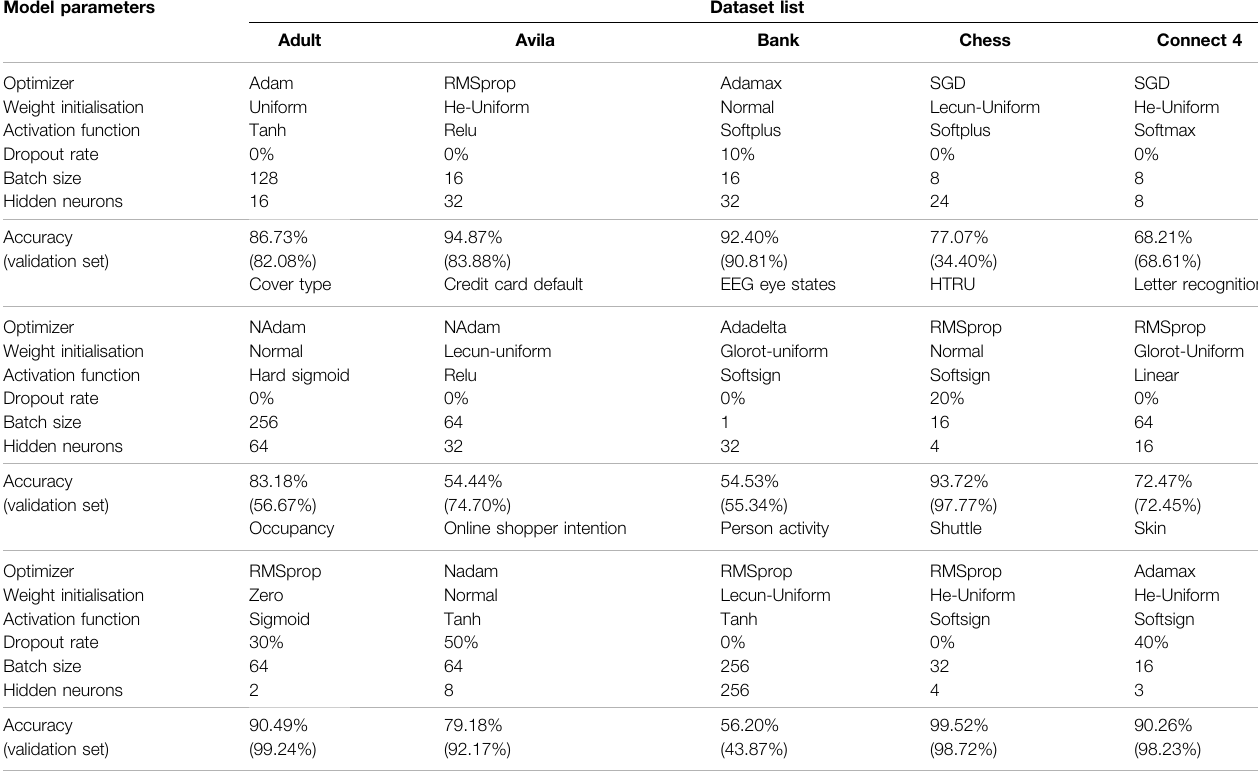
TABLE 2 | Optimal hyperparameters of neural networks obtained through grid search procedure, grouped by dataset, and their resulting accuracies. Model